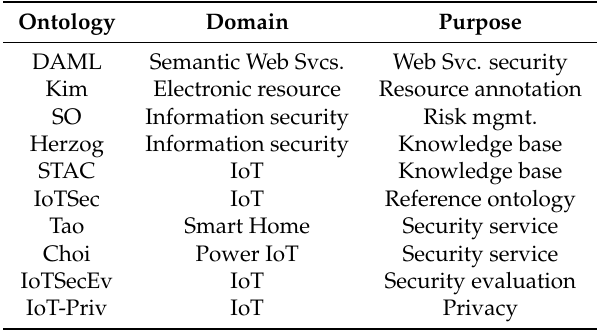
Table 1. Comparison table of the different analysed ontologies. Ontology Domain Purpose DAML Semantic Web Svcs. Web Svc. security Kim Electronic resource Resource annotation SO Information security Risk